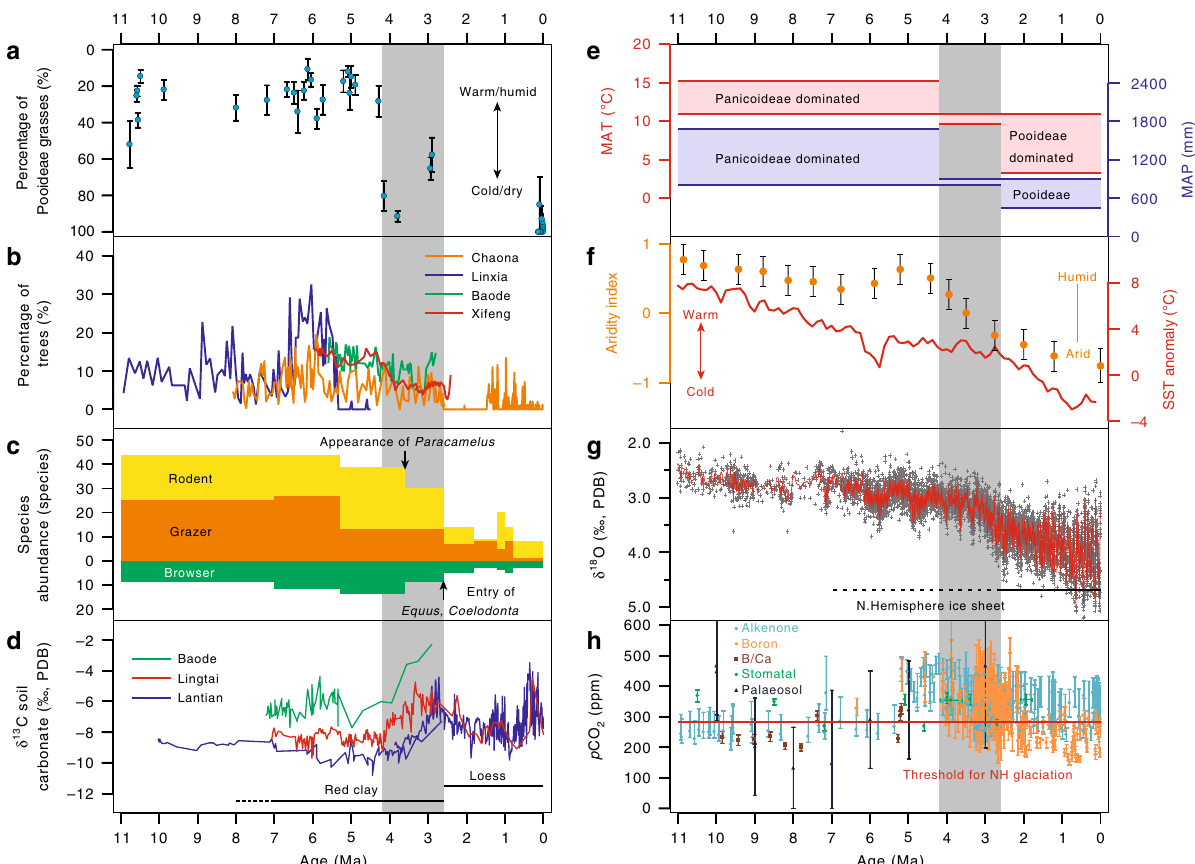
Fig. 4 Reconstructed climate change in East Asia and the comparison with sea surface temperature, benthic oxygen isotope and atmospheric CO 2 level since ~11.0 Ma. a The percentage of Pooideae grasses estimated by phytolith assemblages, which were used as a proxy for temperature and/or precipitation. The error bars are calculated from the con fi dence intervals (95% unconditional case) of each sample using the total count as the sample size. b The percentage of trees derived from palyno fl ora in Xifeng 30 , Baode 31 , Linxia 32 and Chaona 33,34 as a percentage of broadleaf trees of palyno fl ora. c Species abundance of different types since the late Miocene in northern China. Browsers are large mammals with low-crowned teeth (brachydont) that lived in more humid environments and grazers are large mammals with high-crowned teeth (hypsodont) that lived in more arid conditions. Fossil mammal data of the late Miocene and Pliocene are from Wang et al. 17 and those of the Quaternary are from Xue et al. 37 . d Soil carbonate δ 13 C records from Baode 6,57 , Lingtai 4 and Lantian 5,22 . PDB, PeeDee Belemnite. e Phytolith-based quantitative reconstruction of mean annual temperature (MAT) and mean annual precipitation (MAP). f Synthesis of pollen and sedimentary records from northwest China to illustrate the evolution of aridity and the monsoon climate 46 ; synthesis of sea surface temperature (SST) anomalies for the Northern Hemisphere (30 – 50°) based on U k 0 records from four locations 52 . 37 g Benthic 18 O composite. h Synthesis of published p CO 2 proxy data obtained through a variety of different methodologies. For data sources, see Supplementary Note 3. The grey highlighted intervals indicate the Pliocene cooling (4.2~2.6 Ma) suggested by this